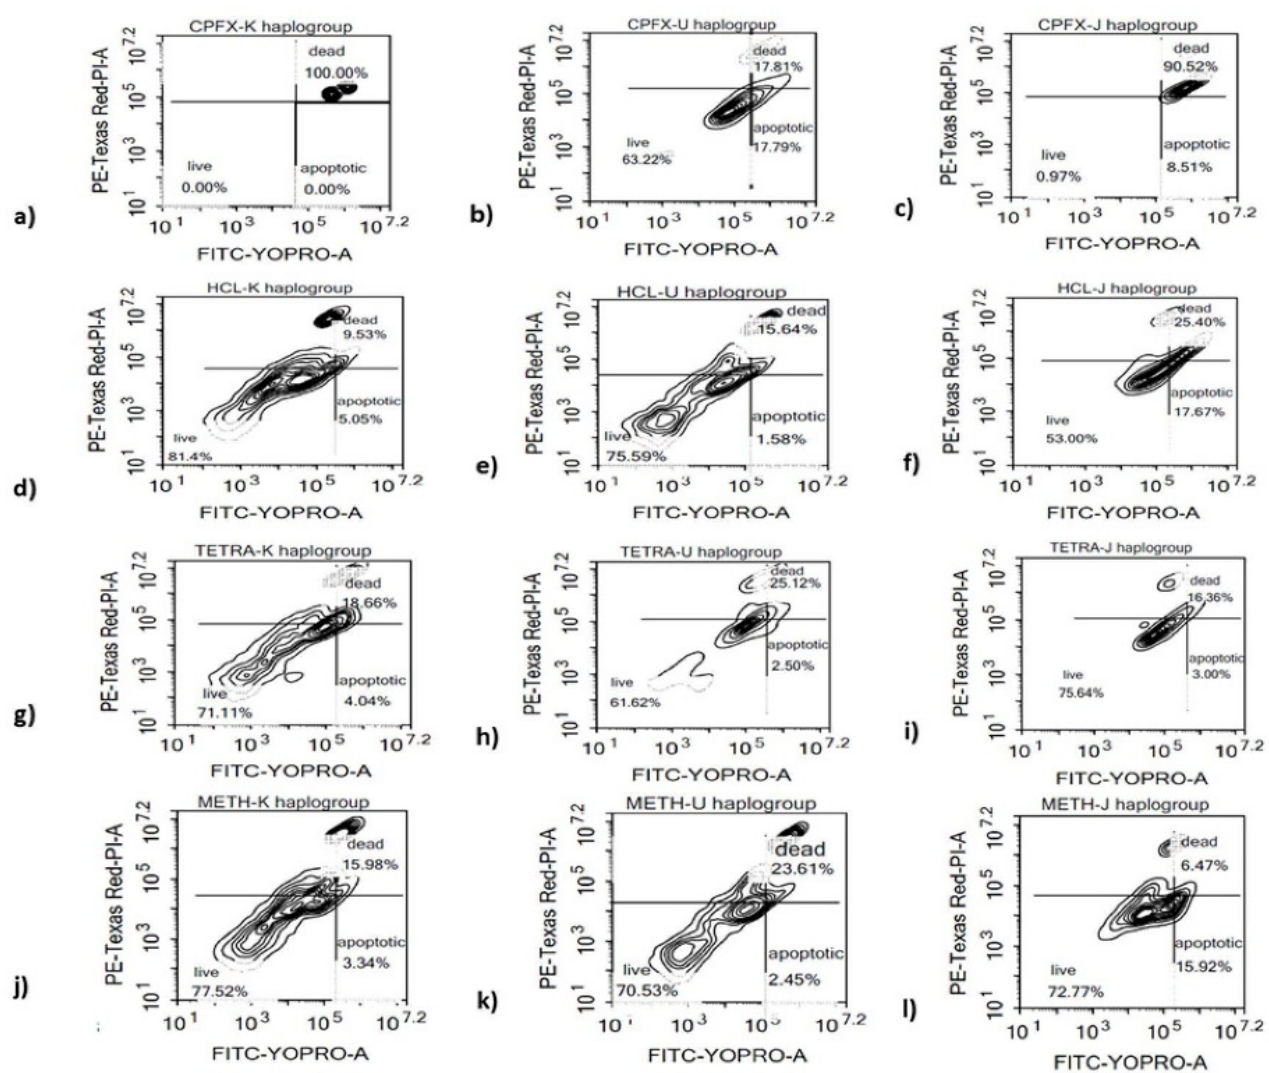
Figure 2. Effects of CPFX and TETRA on the ratio of live, apoptotic and dead cells of K, U and J cybrids. ( a , d , g , j ) higher relative ratio of apoptotic and dead K cybrids via CPFX and TETRA; ( b , e , h , k ) No significant change in ratio of apoptotic and dead cells via either treatment in U cybrids; ( c , f , i , l ) elevated ratio of apoptotic and dead J cybrids vi CPFX and TETRA.